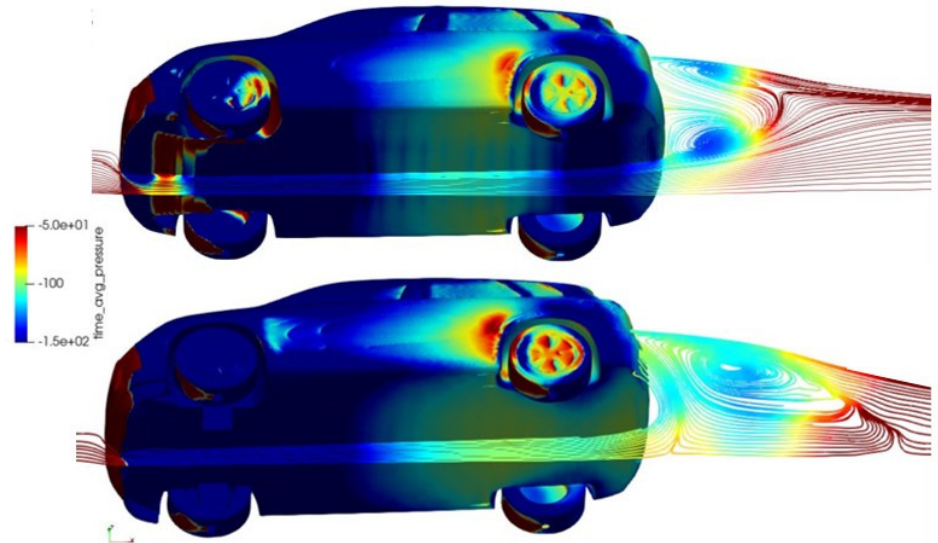
Figure 8. Streamlines in the middle longitudinal section colored by the pressure field. Existing recirculation without air dam ( top view ) behind the rear bumper disappears with air dam ( bottom view ).